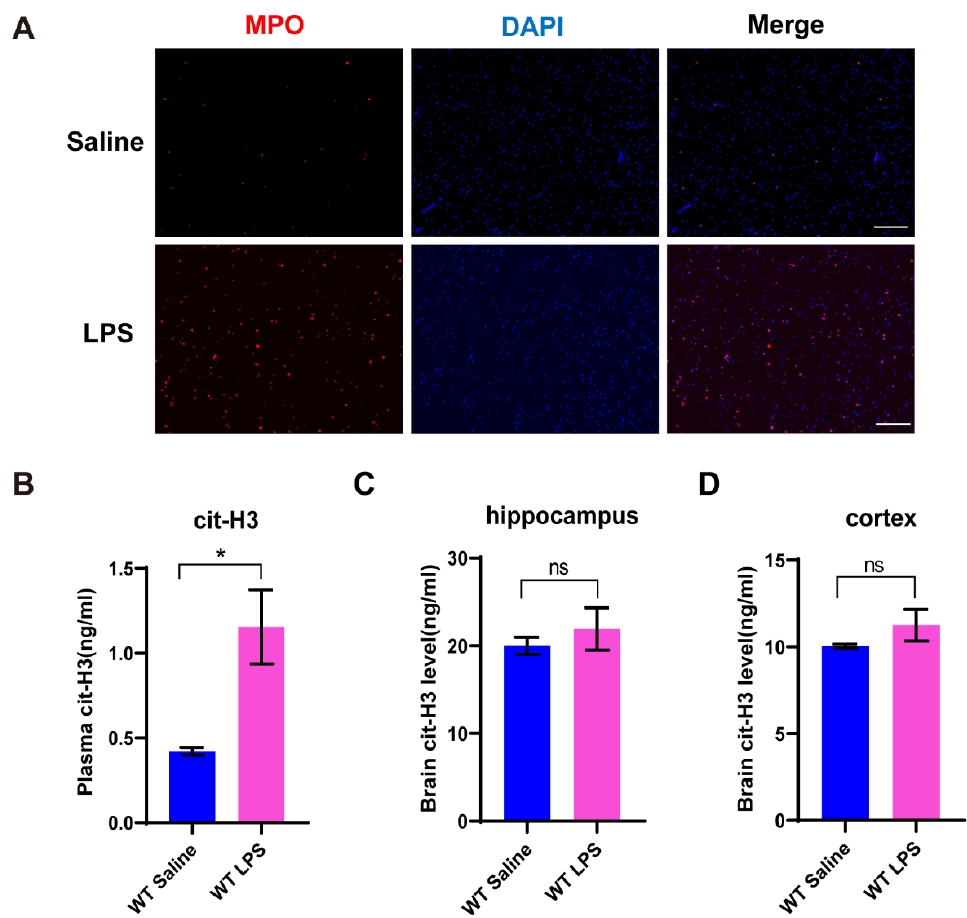
Figure 1. LPS administration intraperitoneally does indeed induce NETs in peripheral blood. ( A ) Neutrophils were extracted from peripheral blood, in mice that were injected with saline and LPS, respectively. Myeloperoxidase (MPO) is one marker of NETs. ( B ) cit-H3 is another marker of NETs. The level of cit-H3 in plasma was measured by ELISA. ( C , D ) Brain tissues were separated into hippocampus and cortex, then tested the level of cit-H3 in brain homogenate by ELISA. Data were expressed mean ± SEM. * p < 0.05 as compared to saline-treated control. n = 4 for ELISA test; n = 3 for immunostaining .